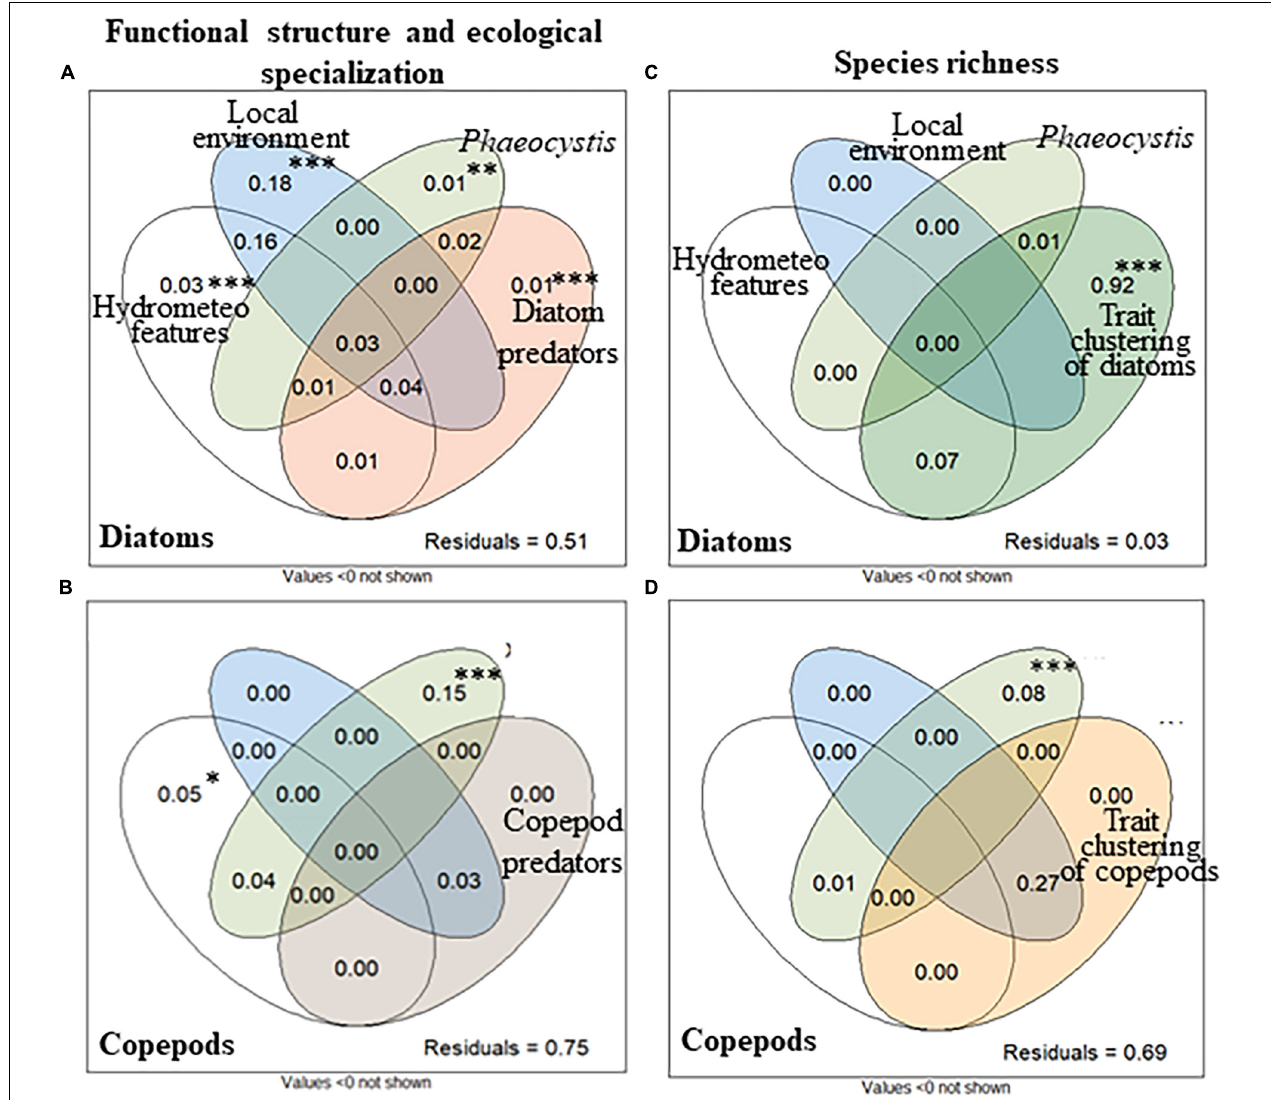
FIGURE 7 | Variation partitioning of the effect of water masses movement and hydrometeorological features (wind stress and direction, white circle), local environment (abiotic and prey biomass, blue circle), Phaeocystis biomass (light green circle), predator patterns (light brown: maximum.size of copepods, and biomass of copepods and protozooplankton for diatoms; dark brown: biomass of fish larvae, chaetognaths and jellyfish for copepods), biotic interaction (trait clustering as a proxy; dark green: diatoms, orange: copepods; using SES-RaoQ), the interactions, and the residual proportion on the (A,B) functional structure and the ecological specialization and (C,D) species richness of the (A,C) diatom and (B,D) copepod communities in coastal waters of the eastern English Channel over the period 2007–2013. Proportions of variations [adjusted r 2 calculated from redundancy analysis (rda)] in the response variables explained by the explanatory ones are shown. The statistical significance of proportions is calculated by permutation test for rda ( ∗∗∗ p = 0.001, ∗∗ p = 0.005, and ∗ p < 0.05). Variance values below are not shown. Note that the shared partitions cannot be tested for statistical